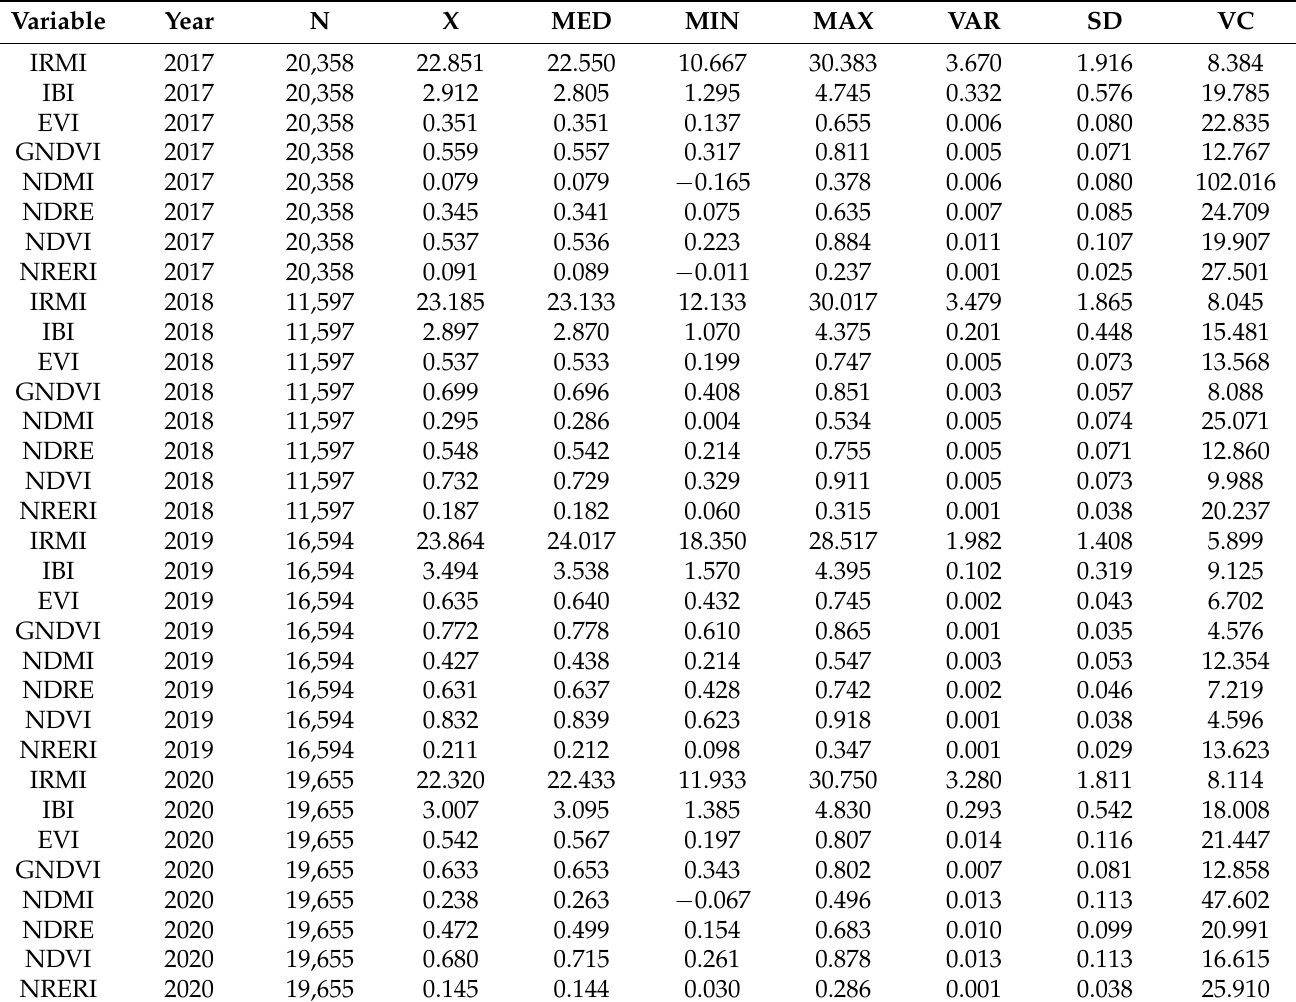
Table A1. Results of descriptive statistics—vegetation indexes for individual years (2017, 2018, 2019,